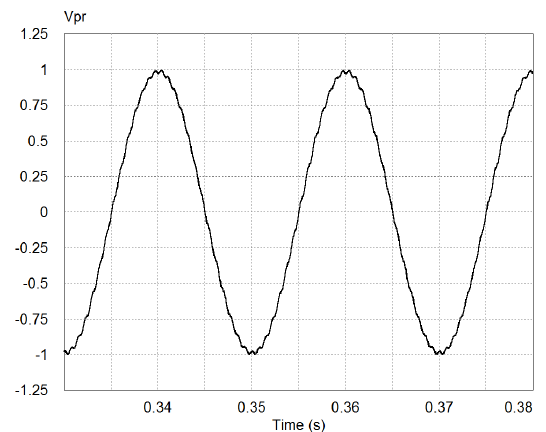
Figure 14. Transient and steady-state current unbalance in converters 1 and 2. Traces: Is1 - AC current of converter 1, Is2 - AC current of converter 2, Ip - primary current.